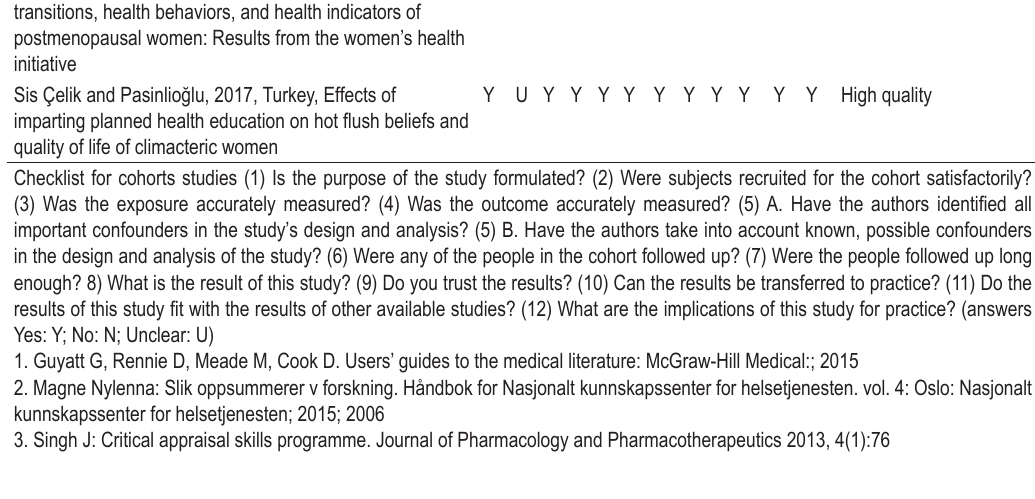
TABLE 5. Quality assessment of the included studies with an RCT